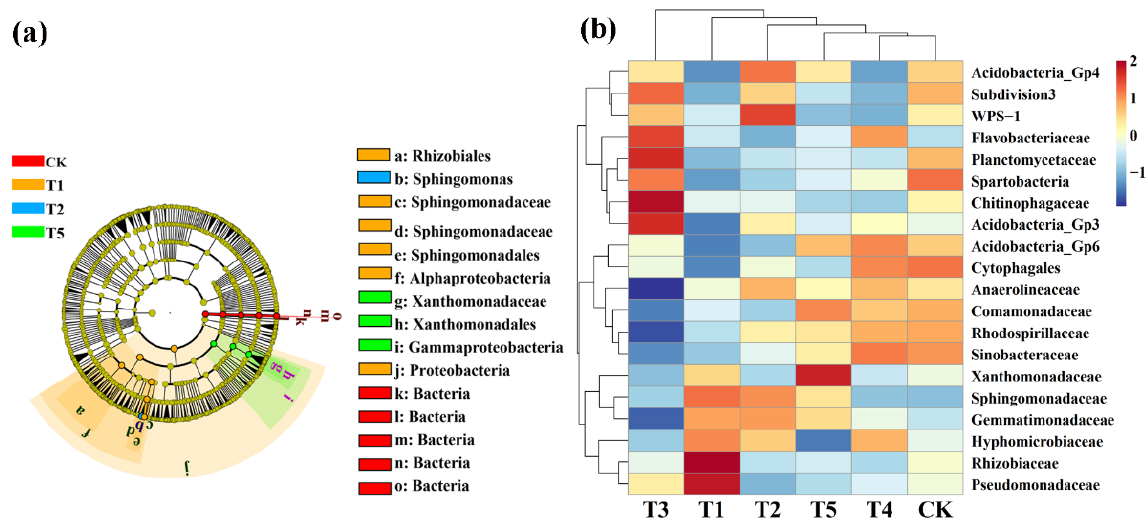
Figure 6. Linear discriminant analysis (LDA) effect size (LeFse) of the bacterial taxa ( a ), which identifies the most differentially abundant taxa among the different microbial fertilizer treatments. Only taxa with LDA values greater than 4 ( p < 0.05) are shown. Hierarchical clustering analysis and heat mat at the family level ( b ). The tree plot represents a clustering analysis of the top 20 bacteria at the family level according to their Person correlation coefficient matrix and relative abundance; the upper tree plot represents a clustering analysis of soil samples according to the Euclidean distance of data. T1, T2, T3, T4, T5, and CK represent the treatment of Tuzangjin microbial fertilizer (TMF), carbonergic microbial agent (CMA), seaweed microbial fertilizer (SMF), sheep manure (SM), chemical compound fertilizer (CCF), and the control (CK), respectively.